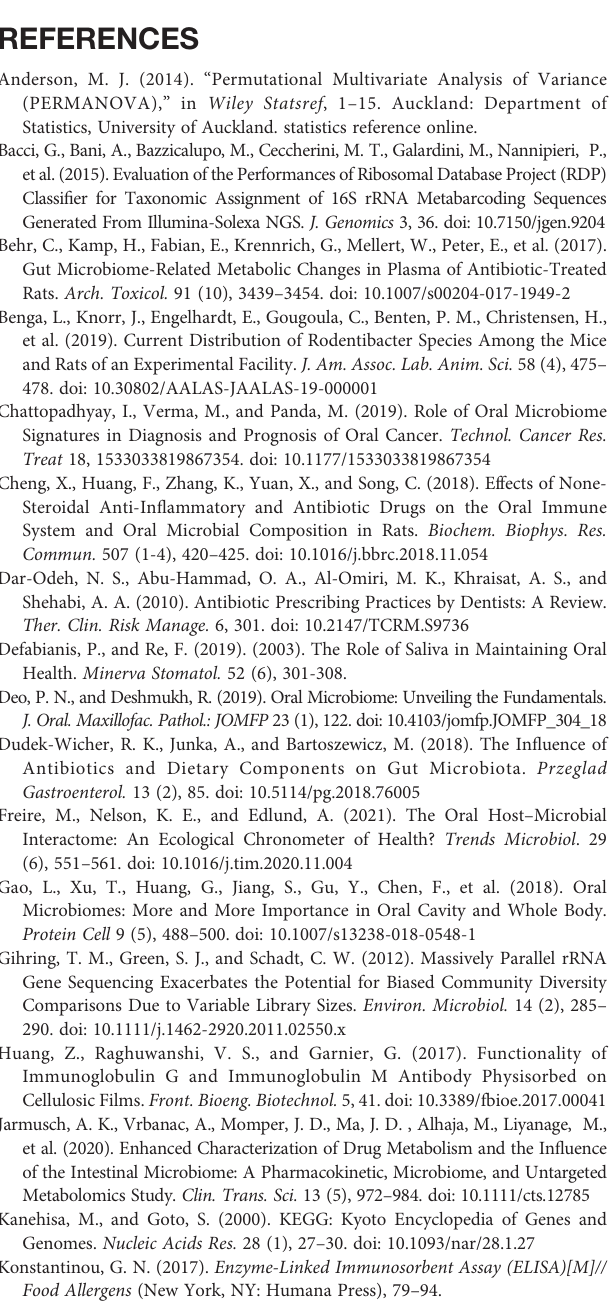
Supplementary Figure 7 | Rarefaction analysis of bacterial 16S rRNA genesequences. Supplementary Table 1 | Antibiotic species and their target strains. Supplementary Table 2 | Samples read counts. Supplementary Table 3 | Comparison of signi fi cant bacterial genus in all groups. Supplementary Table 4 | Multi-group difference statistics table (phylum level). Supplementary Table 5 | Multi-group difference statistics table (Genus